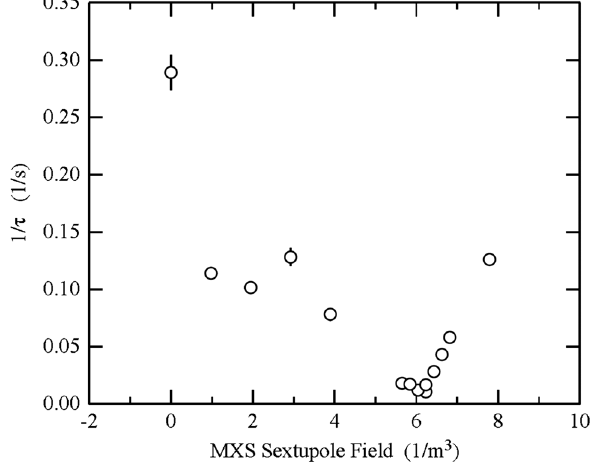
FIG. 14. Measurements of 1 / τ of the IPP for scan 2 and a wide beam. The value of MXG was zero. Errors shown arise only from the fit of the polynomial to the early time measurements as shown in Fig. 10. Only the points for the spin down polarization state are shown. In general, the two polarization states agree well.